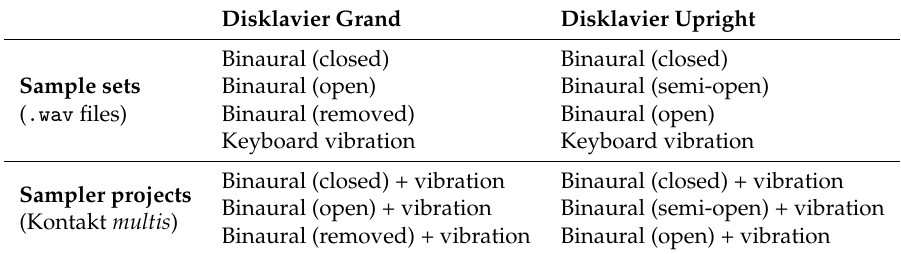
Table 1. Binaural and vibratory (BiVib) core structure. Piano lid configurations are given in square